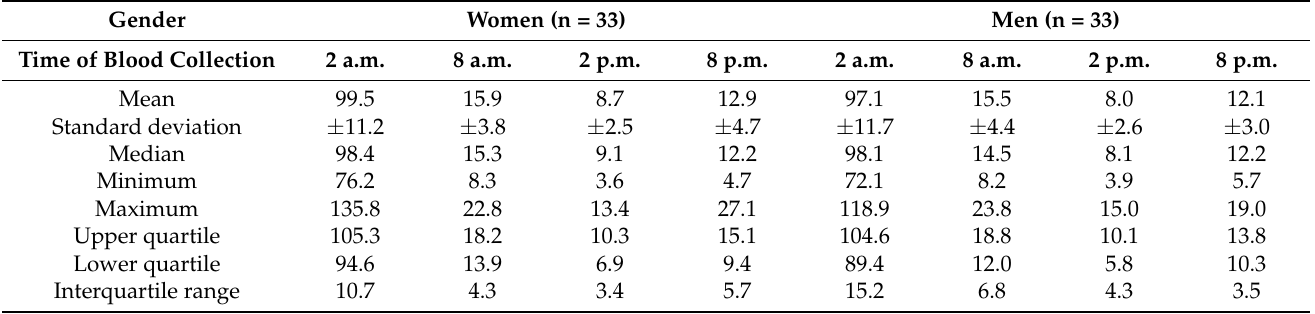
Table 2. Parameters describing melatonin concentration in women and men, including the time of blood collection